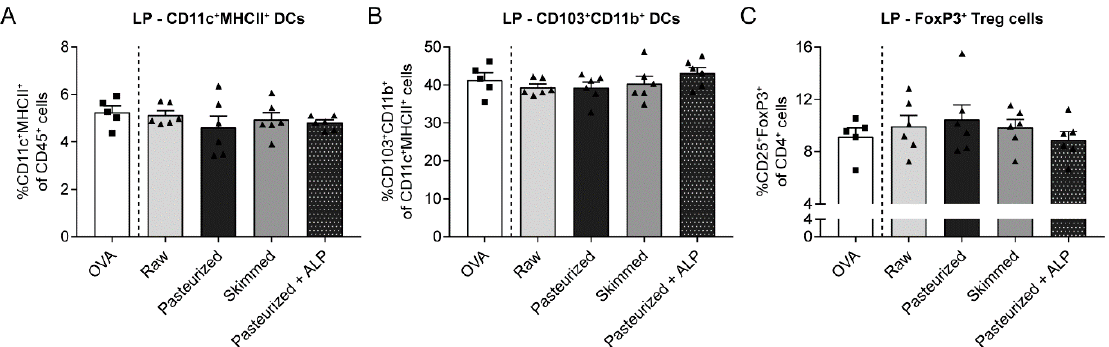
Figure 5. Different milk types did not affect tolerogenic DC and Treg cell frequency in the LP. ( A ) Percentage of CD11c + MHCII + DCs (CD11c + MHCII + of CD45 + cells), ( B ) CD103 + CD11b + DCs (CD103 + CD11b + of CD11c + MHCII + cells) and ( C ) FoxP3 + Treg cells (CD25 + FoxP3 + of CD4 + cells) in the LP. Data are presented as mean ± SEM, including individual data points, n = 5–6/group. No significant differences were observed. LP, lamina propria; PBS, phosphate-buffered saline; OVA, ovalbumin; raw, raw cow’s milk; pasteurized, pasteurized cow’s milk; skimmed, skimmed raw cow’s milk; pasteurized + ALP, pasteurized milk spiked with alkaline phosphatase.